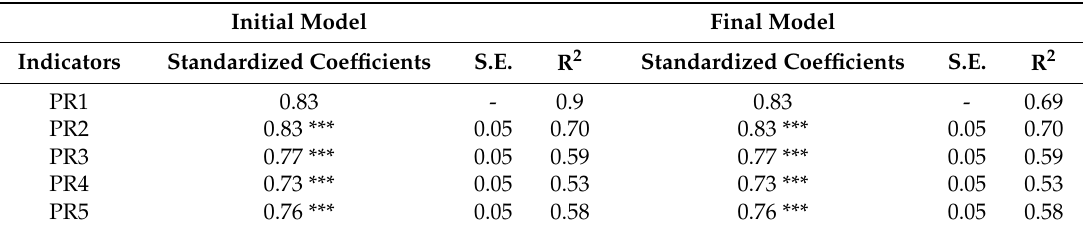
Table 4. Estimated measurement model.